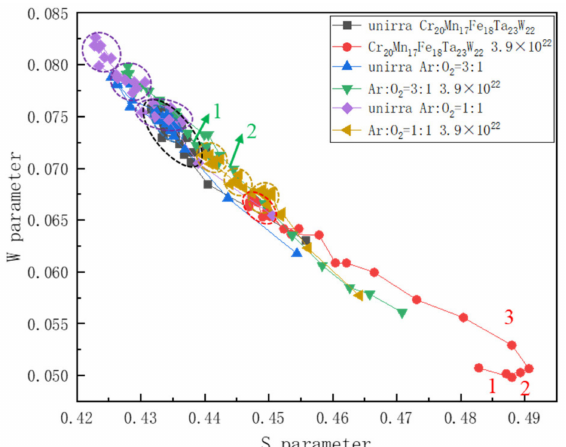
Figure 13. W—parameter as a function of S—parameter for Cr 20 Mn 17 Fe 18 Ta 23 W 22 , HT1 and HT3 specimens before and after H + irradiation. The numbers represent the slope